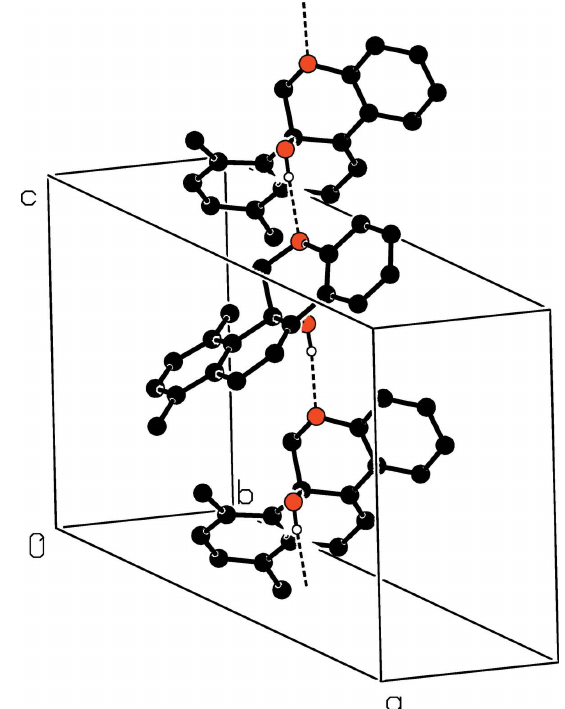
Figure 3 Part of the crystal structure with O—H (cid:3)(cid:3)(cid:3) O hydrogen bonds shown as dashed lines.